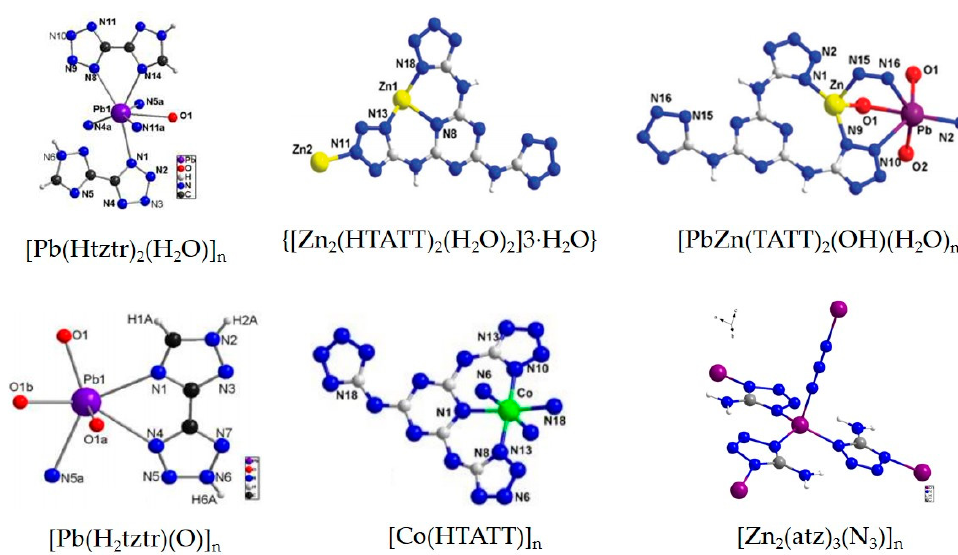
Figure 1. The structure diagram for the EMOFs mentioned above.